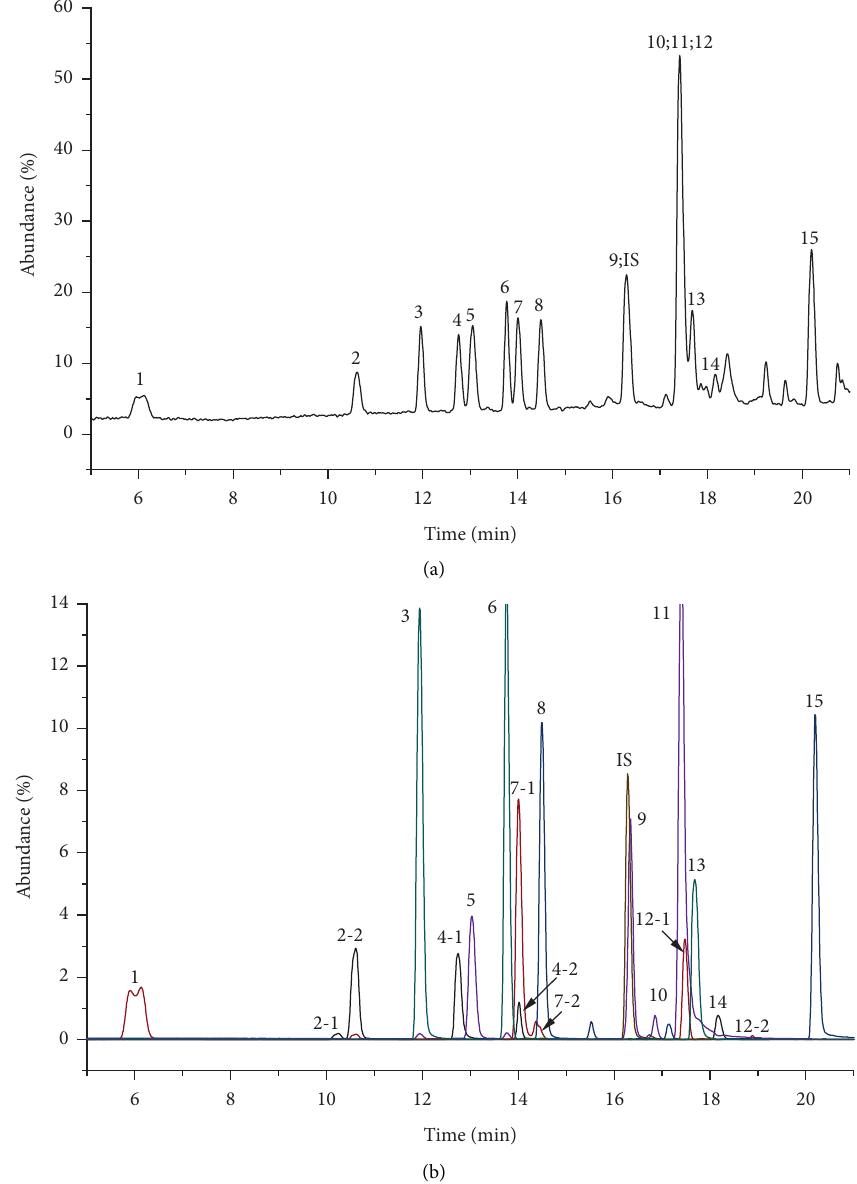
Figure 1: UPLC-MS/MS chromatogram of polyphenolic compounds in full scan mode (a) and MRM scan mode (b). The peak no. was as shown in Table 1, and DFA was used as